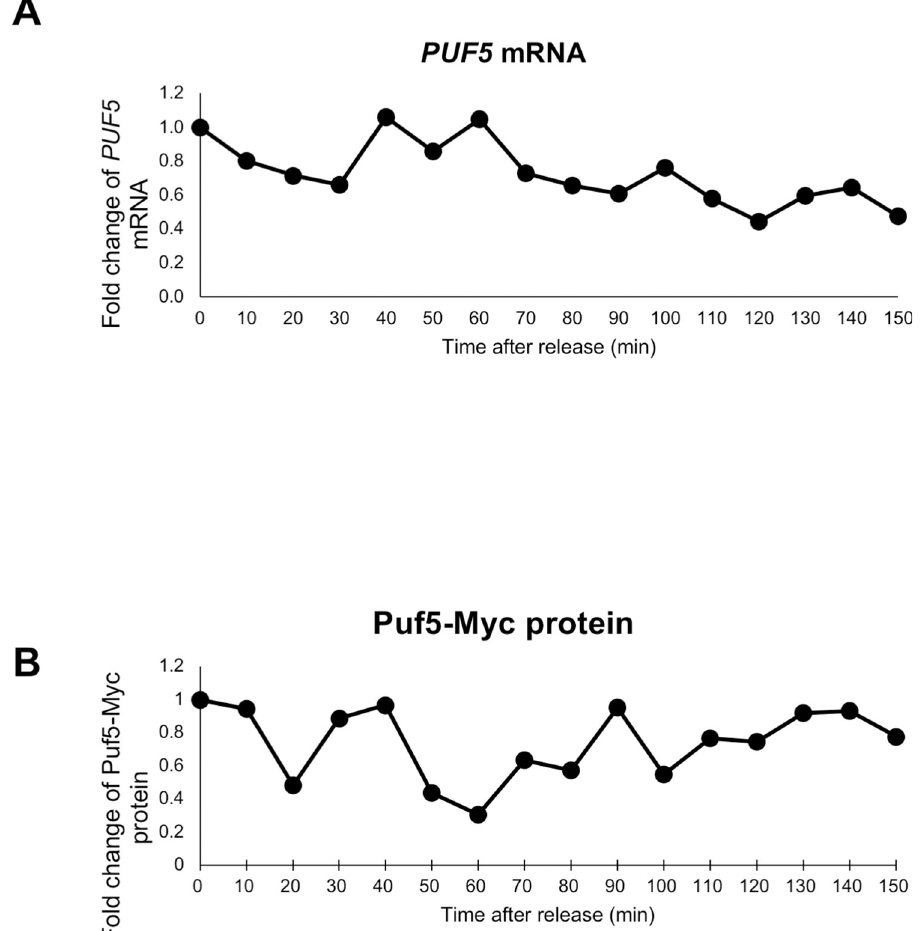
Fig 12. PUF5 expression is invariable during the cell cycle. (A) The cell cycle-dependent mRNA levels of PUF5 in the synchronized bar1 Δ cell, the same sample used in Fig 9. The cell cycle was arrested in the G1 phase by α -factor, and, after release, cells were collected from 0 min (just before releasing) to 150 min. The levels of PUF5 mRNA were quantified by qRT-PCR analysis, and the relative mRNA levels were calculated using the SCR1 reference gene. The vertical axis shows the fold change of mRNA relative to the mRNA level in the bar1 Δ 0 min sample, and the horizontal axis shows the time after release. (B) The cell cycle-dependent Puf5 protein level in the synchronized bar1 Δ cell integrated PUF5-13Myc-ADH1 3´ UTR gene. The cell cycle was arrested in the G1 phase by α -factor, and, after release, cells were collected from 0 min (just before releasing) to 150 min. The extracts were immunoblotted with anti-Myc antibody or anti-Pgk1 antibody. The blot image is presented in S5A Fig. Puf5-Myc protein level was quantified and normalized with the Pgk1 protein level. The vertical axis shows the fold change of protein relative to the protein level in the bar1 Δ 0 min sample, and the horizontal axis shows the time after